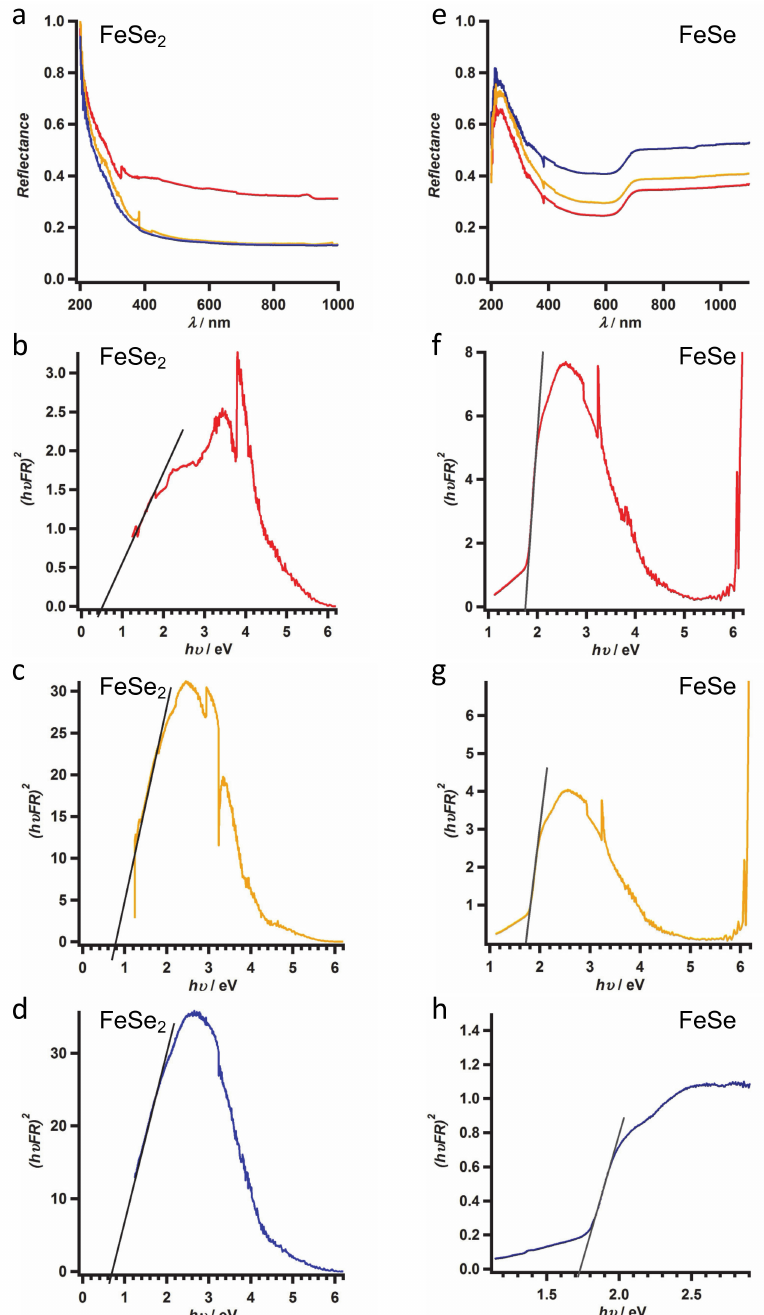
Figure 6. Optical band gap estimation of FeSe 2 ( a – d ) and FeSe ( e – h ) from the reflectance measure- ment, different colour solid line attributed to the same sample in different measurement. The bandgap values of FeSe 2 ( b – d ) and FeSe ( f – h ) are collected from the intercepts on the